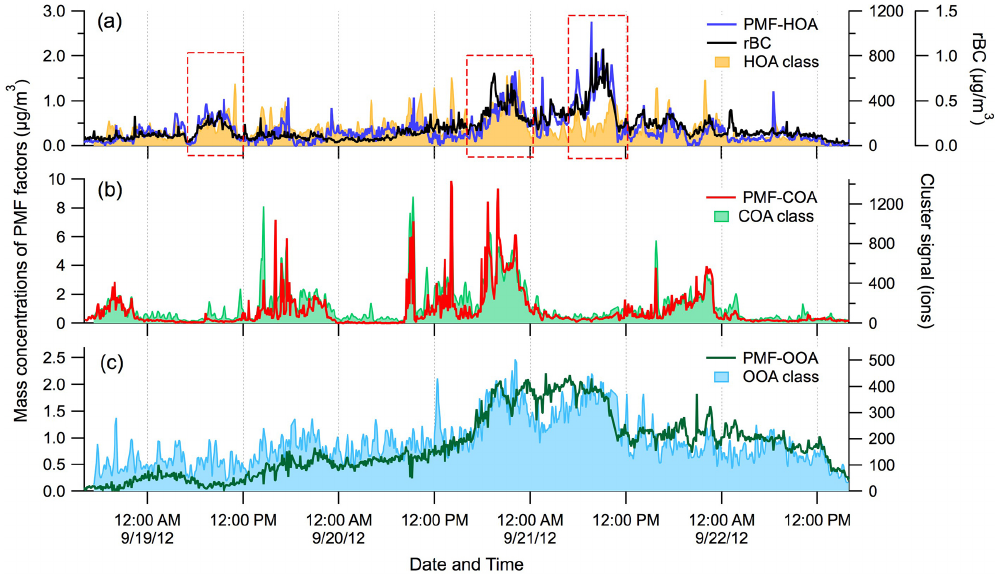
Figure 4. Time series (local time) profiles of rBC and PMF factors of organic components (from laser-off-mode MS measurements) and different organic clusters (from laser-on-mode LS measurements). The red rectangles indicate three major rBC and HOA peaks throughout the sampling period.